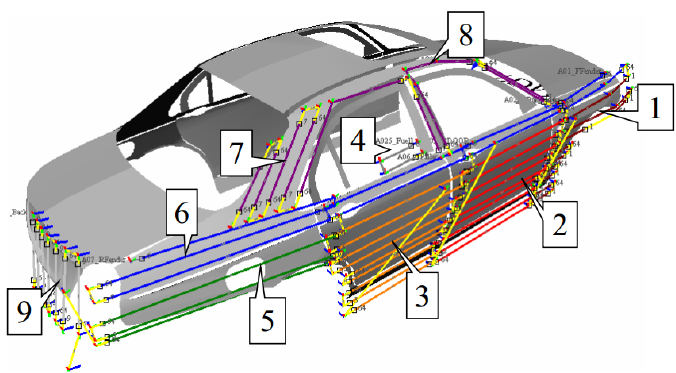
Figure 16. Optimized trajectory on the right and right ‐ rear parts of the automobile.